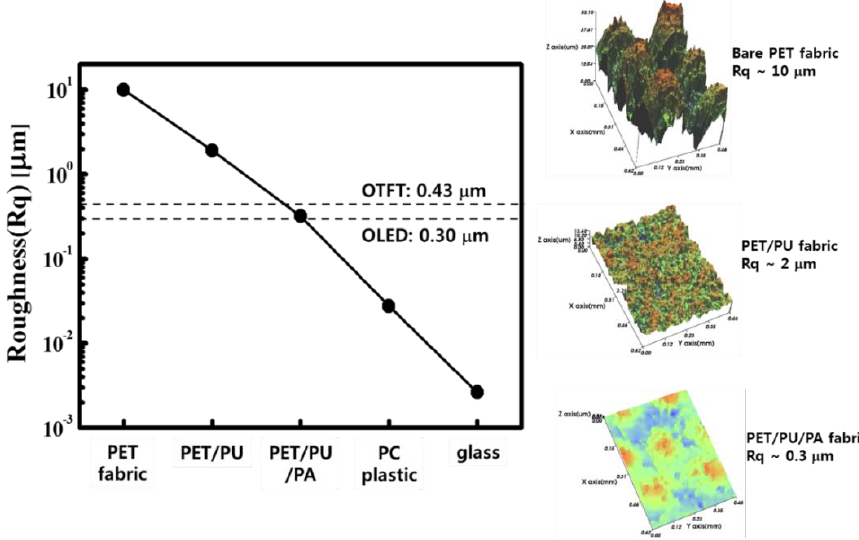
Figure 3. The surface roughness variation of the polyethylene terephthalate fabric substrate according to deposition of the polyurethane (PU) and photo-acryl (PA) layers, including the AFM images of bare PET, PET/PU, and PET/PU/PA fabric substrates.